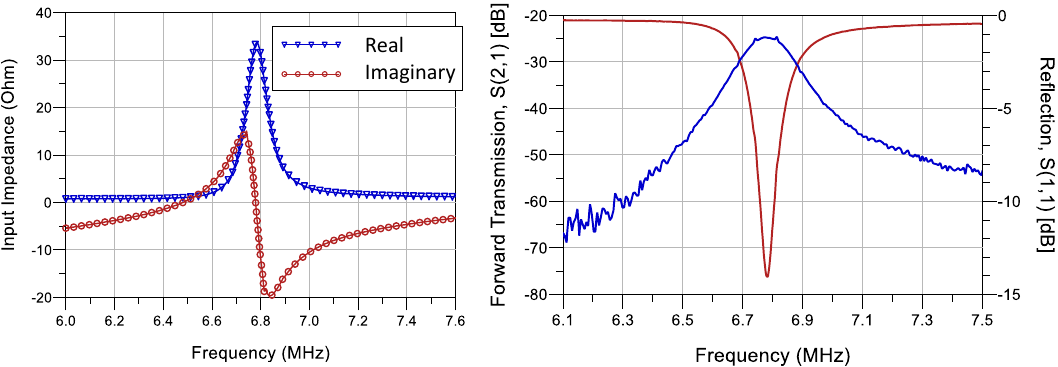
Figure 7. Measured coil input impedance ( Left ) and two-port s-parameters of symmetric matched coils at 10-cm separation ( right